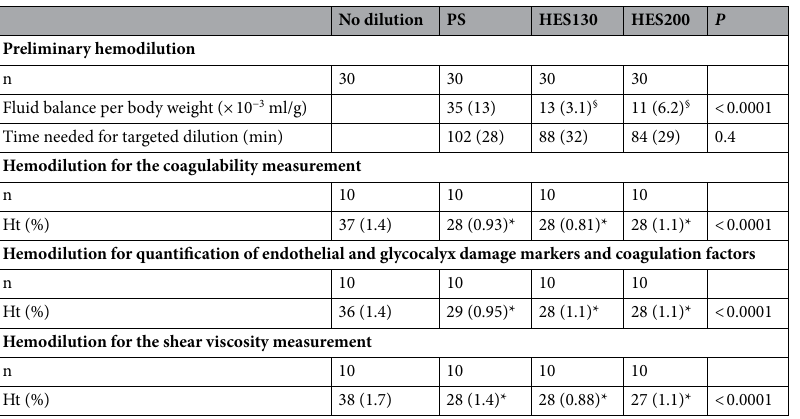
Table 1. Performance of hemodilution. Data are presented as the mean (SD). Ht hematocrit, PS physiological saline, HES 130 6% hydroxyethyl starch 130/0.4 in PS (6% Voluven), HES 200 10% hydroxyethyl starch 200/0.5